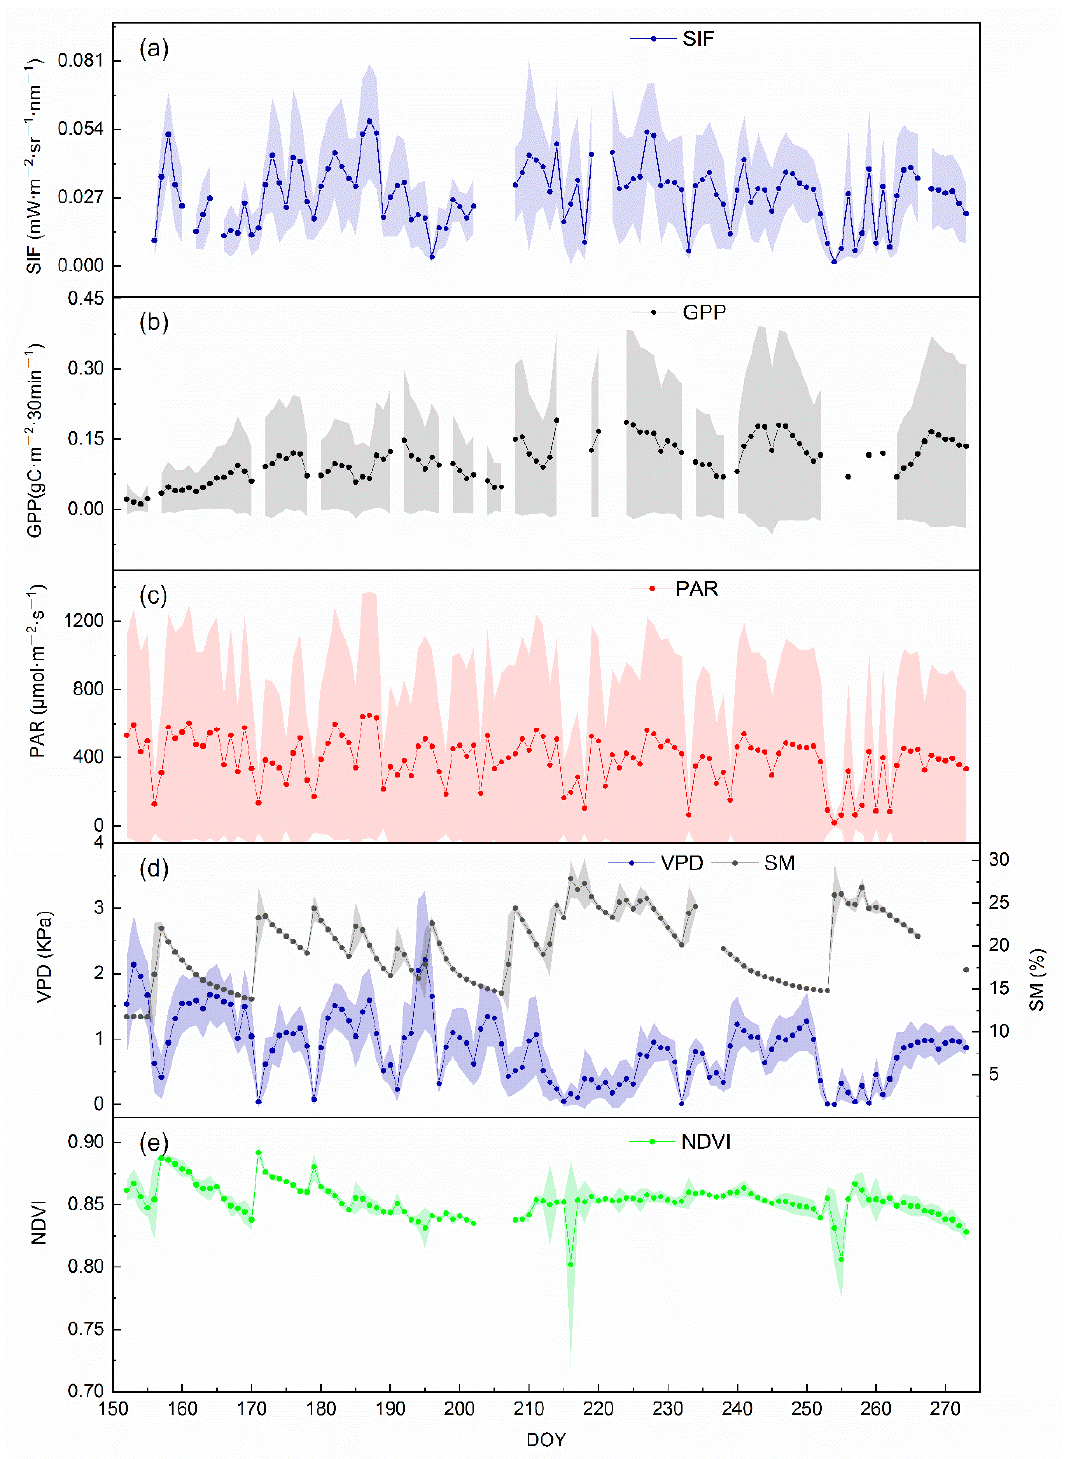
Figure 1. Seasonal patterns of SIF ( a ), GPP ( b ), PAR ( c ), VPD and SM at 20 cm depth ( d ), and NDVI ( e ) derived from Auto-SIF1 system measurements. Dots and shade represent daily means values and standard deviations that were calculated from all 30 min data in the day, respectively.